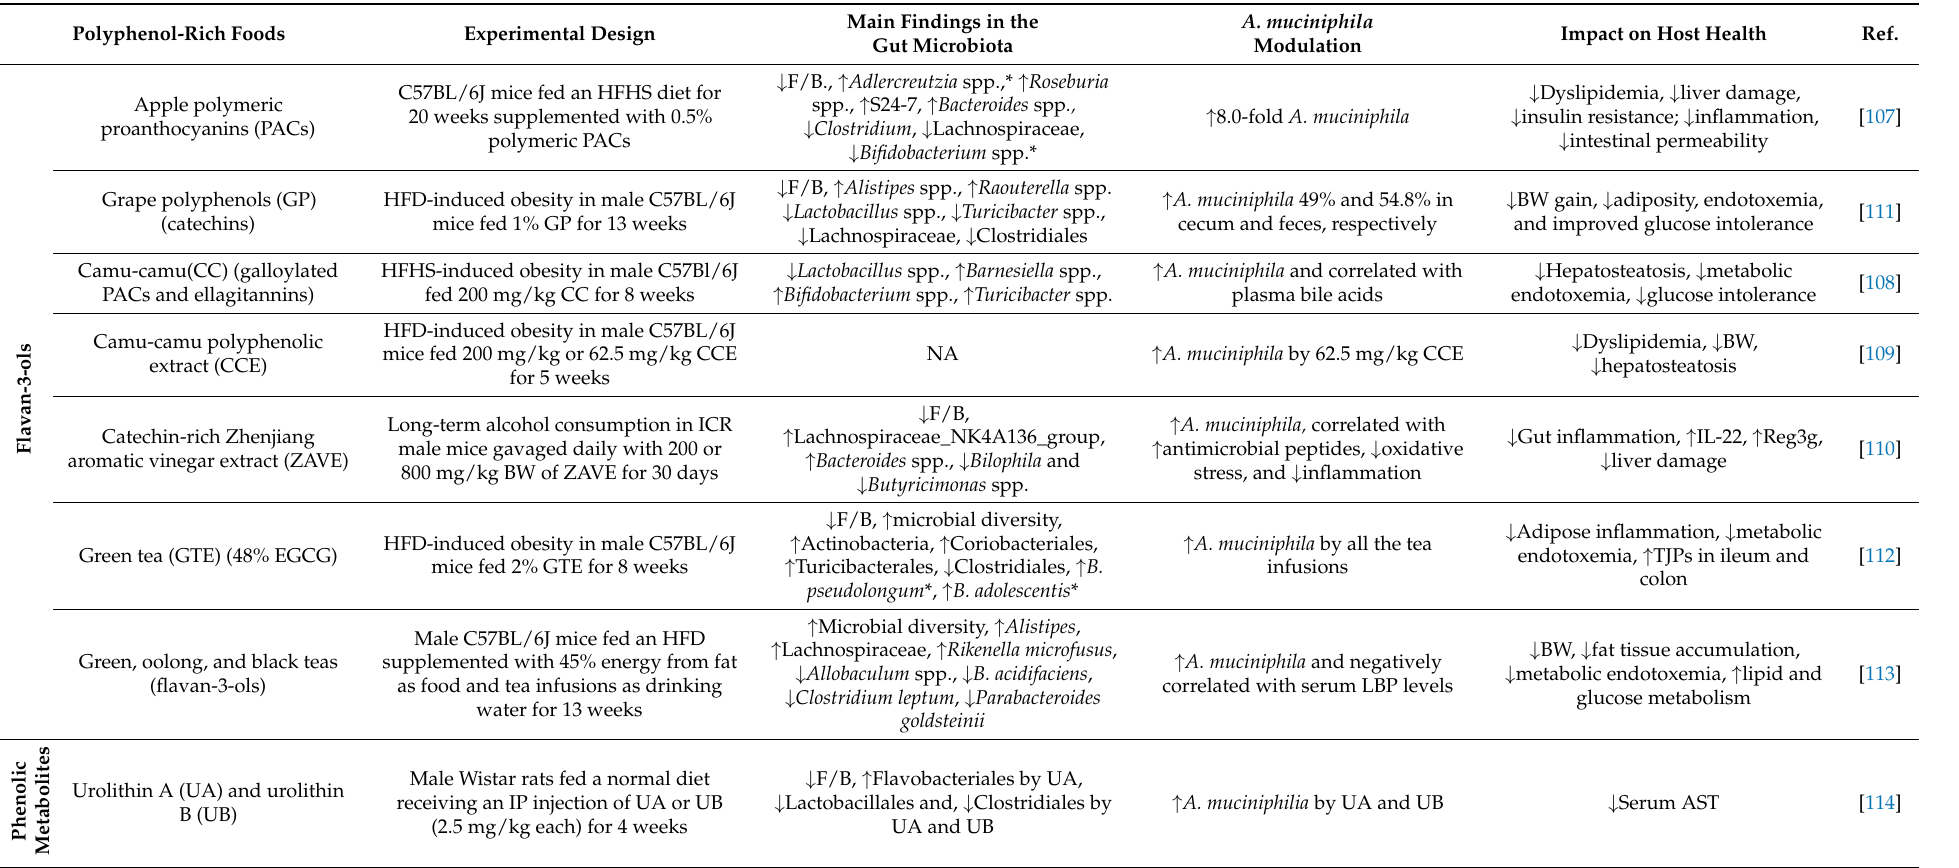
Table 3. Impact of flavan-3-ols and phenolic metabolites on the relative colonic abundance of A. muciniphila and other